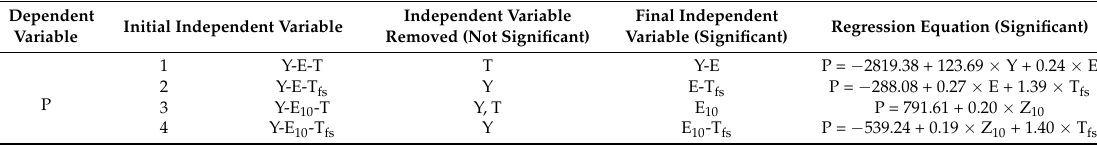
Table 2. Regression equations at a